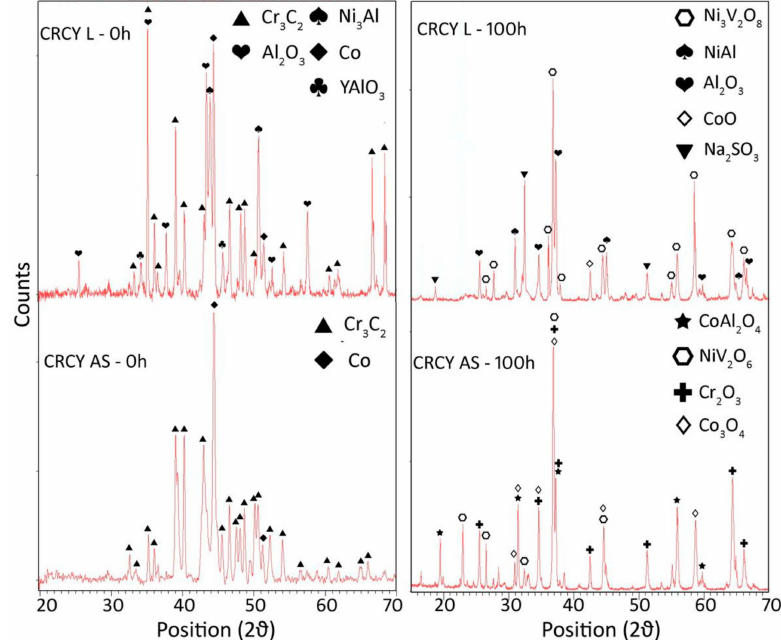
Figure 9. XRD patterns for the CRCY samples: AS—as-sprayed (lower left); L—laser-treated (upper left); AS-100 h—as-sprayed, exposed for 100 h (lower right); L-100h—laser-treated, exposed for 100 h (upper right).